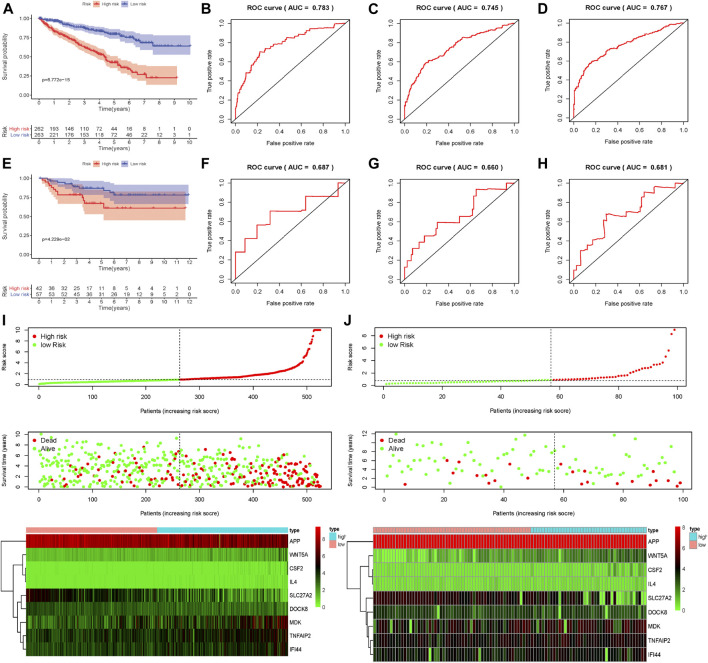
Evaluation and external verification of nine apoptosis-related genes established model; (A) Survival curves of OS from high- and low-risk groups of high- and low-risk divided by riskScore in the TCGA dataset; (B–D) 1-, 3- and 5-year ROC in the TCGA dataset; (E)Survival curves of OS from high- and low-risk groups of high- and low-risk divided by riskScore in the external validation dataset (ArrayExpress); (F–H) 1-, 3- and 5-year ROC in the ArrayExpress dataset; (I,J) The distribution of risk scores for samples, the survival status of patients and the expression heatmap of nine differently expressed genes in the TCGA dataset and the ArrayExpress dataset.